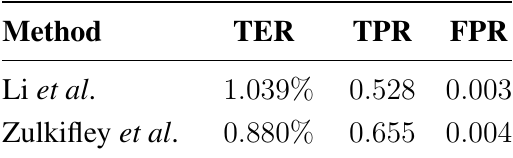
Table 6. Performance comparison between Li et al . method and Zulkifley et al . algorithm.